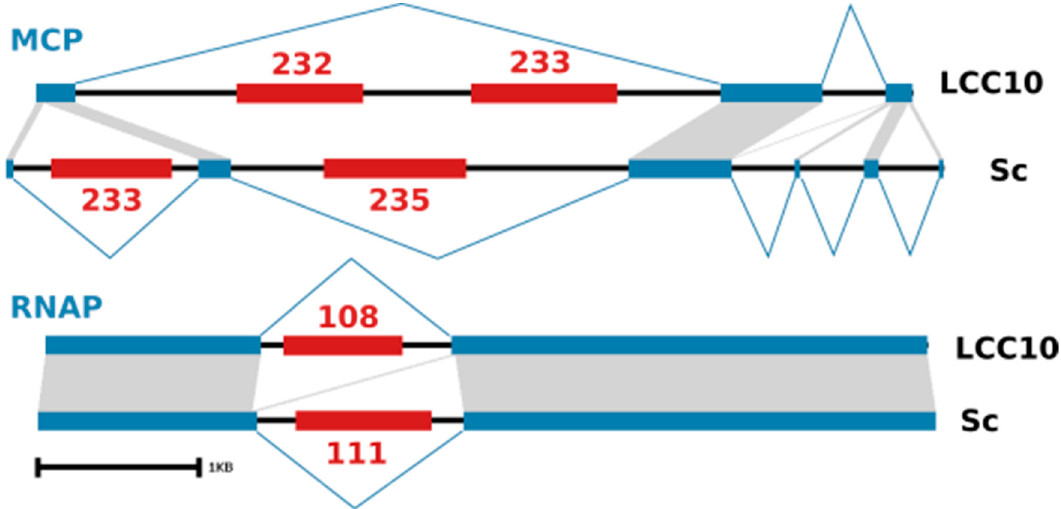
Figure 4. Type-1 introns in KV genes. Schematic representation of the MCP and RNAP genes in the two KV strains (KV-LCC10 above, KV-Sc below). Exons are represented by blue rectangles connected by blue lines showing splicing sites. Nucleotide sequence similarity is indicated by grey shaded areas. Homing endonuclease ORFs are shown by red rectangles, with numbers referring to the gene locus id in the respective Genbank records.